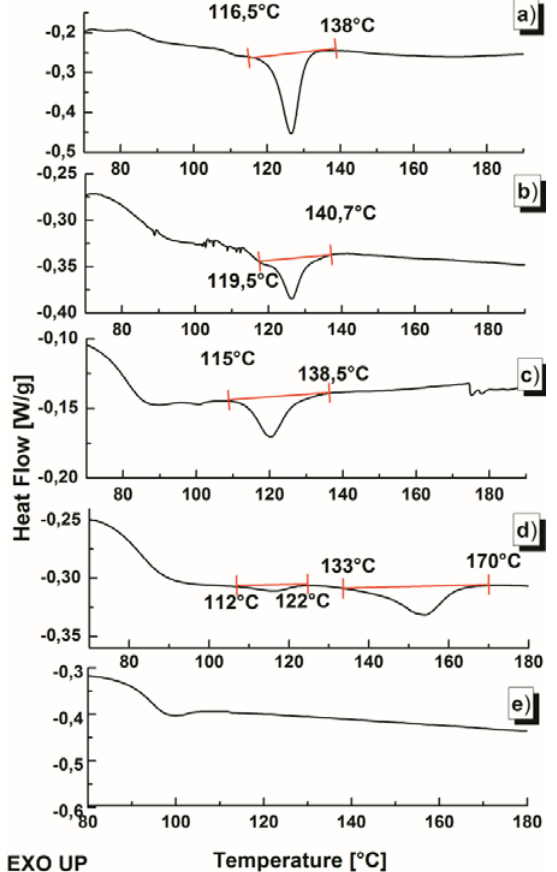
Figure 4. DSC-thermograms of samples obtained by thermal decomposition of different mercaptides in amorphous polystyrene. (a) Silver n-dodecyl-mercaptide; (b) Silver n-hexadecyl-mercaptide; (c) Silver n-octadecyl-mercaptide; (d) Silver 11-mercapto-1- undecacylmercaptide (e) Silver